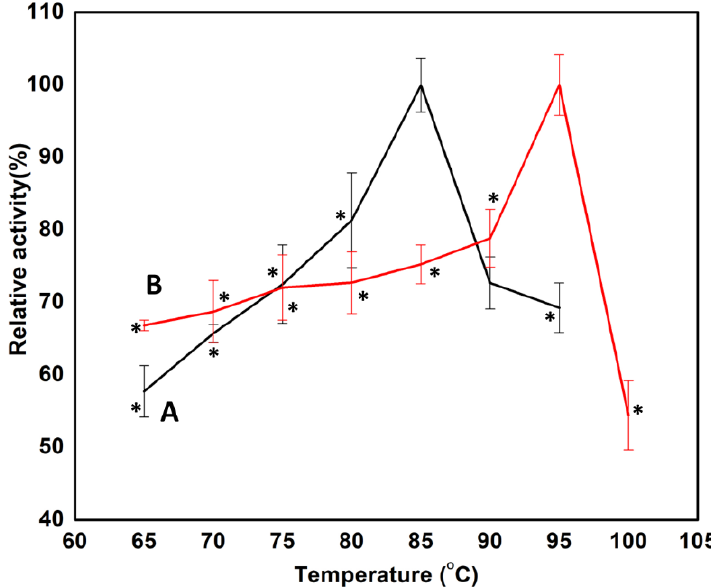
Figure 2. Effect of temperature on the free and immobilized Man/Cel5B activity. (A) Free Man/Cel5B. The temperature values showing significant ( p < 0.05) difference from optimum temperature were marked with ‘*’. (B) Immobilized Man/Cel5B. The temperature values showing significant ( p < 0.05) difference from optimum temperature were marked with ‘*’.